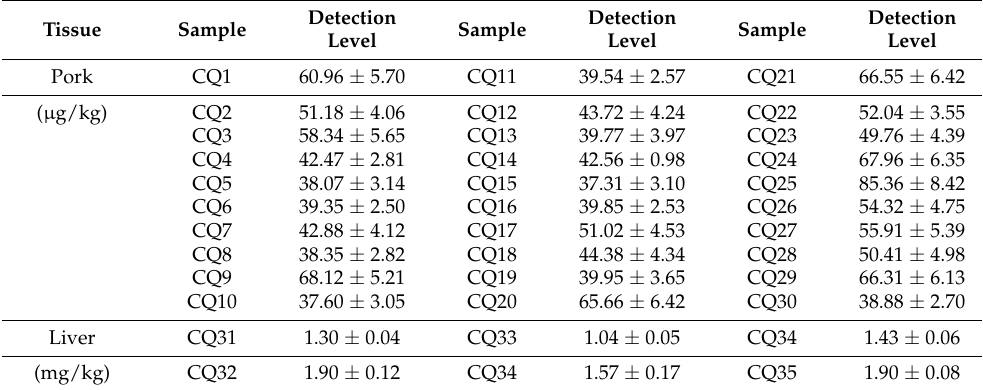
Table 3. Cu (II) content of pig samples from local markets ( n =